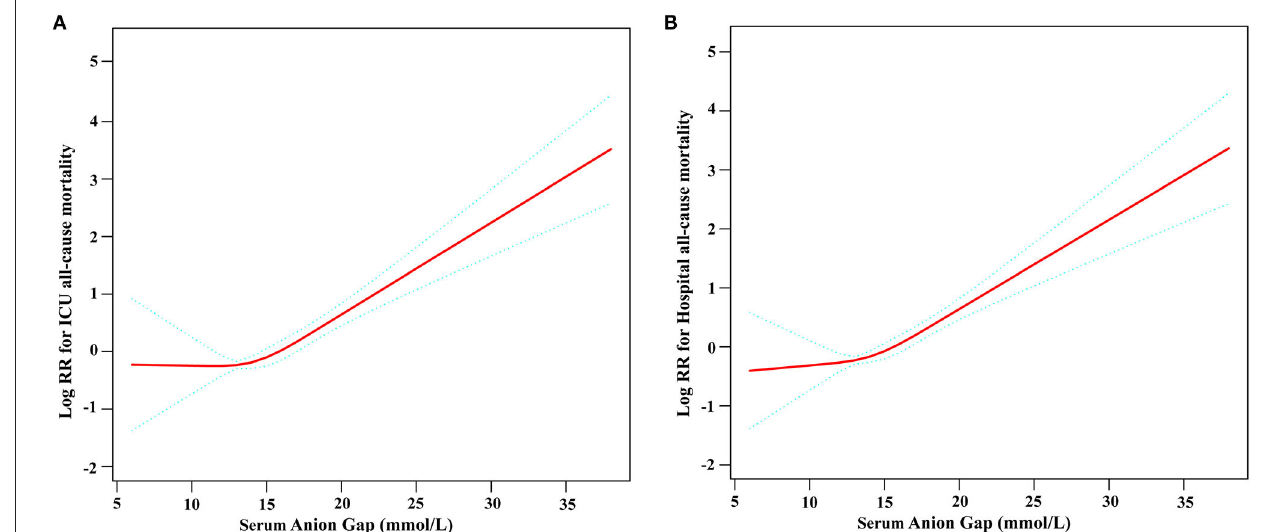
FIGURE 2 | Construction of smooth curve describing the risk of mortality against serum Anion Gap using a restricted cubic spline model. (A) ICU all-cause mortality; (B) Hospital all-cause mortality. The solid red line represents the smooth curve fit between variables. Blue bands present the 95% confidence interval. Data were adjusted for age, sex, ethnicity, SBP, DBP, respiratory rate, GCS, diabetes, sepsis, renal failure, chronic pulmonary disease, vasopressor, embolization of aneurysm, clipping of aneurysm, WBC, platelet, hemoglobin, glucose, BUN, and